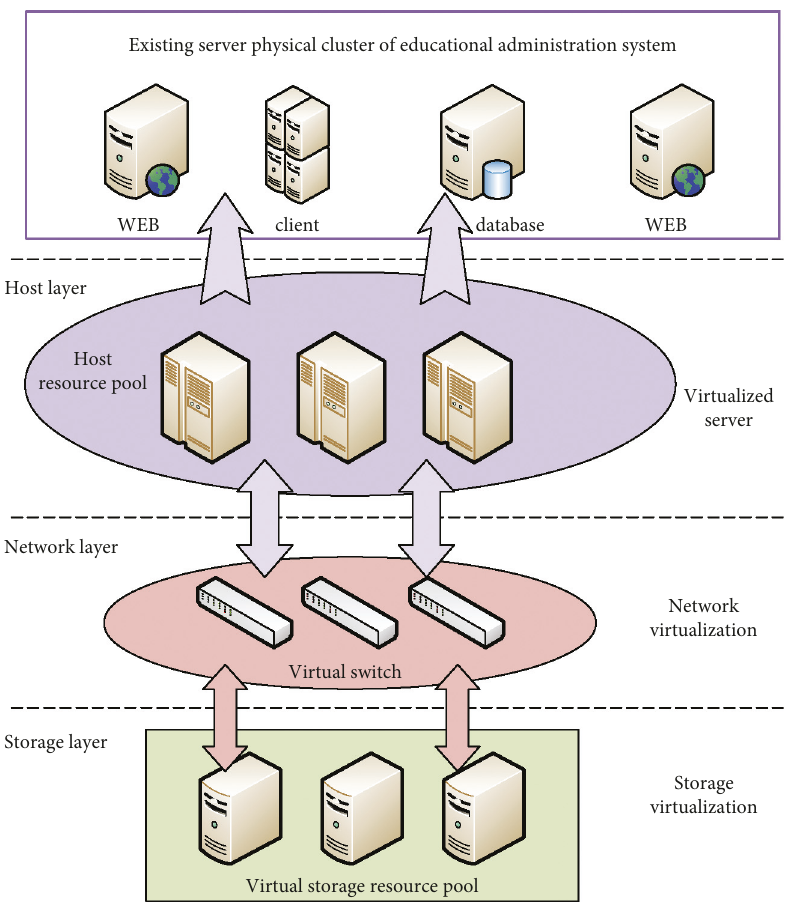
Figure 4: Scheme architecture of cloud computing educational administration system